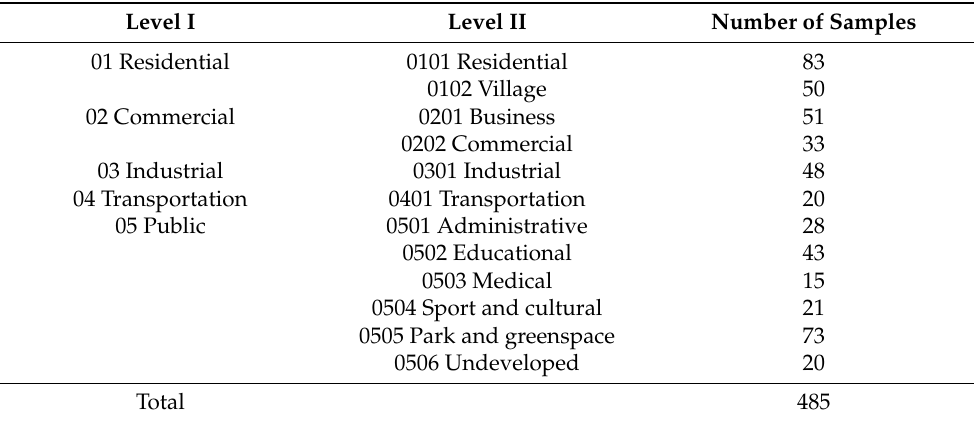
Table 1. Classification system and